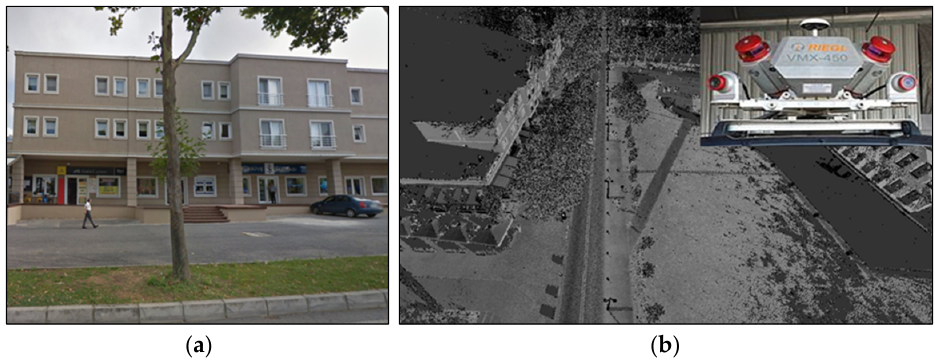
Figure 2. ( a ) ITU Yilmaz Akdoruk guest-house southern facade; ( b ) point cloud of the building facade and its environment measured by using the mobile laser scanning system (Riegl VMX-450).